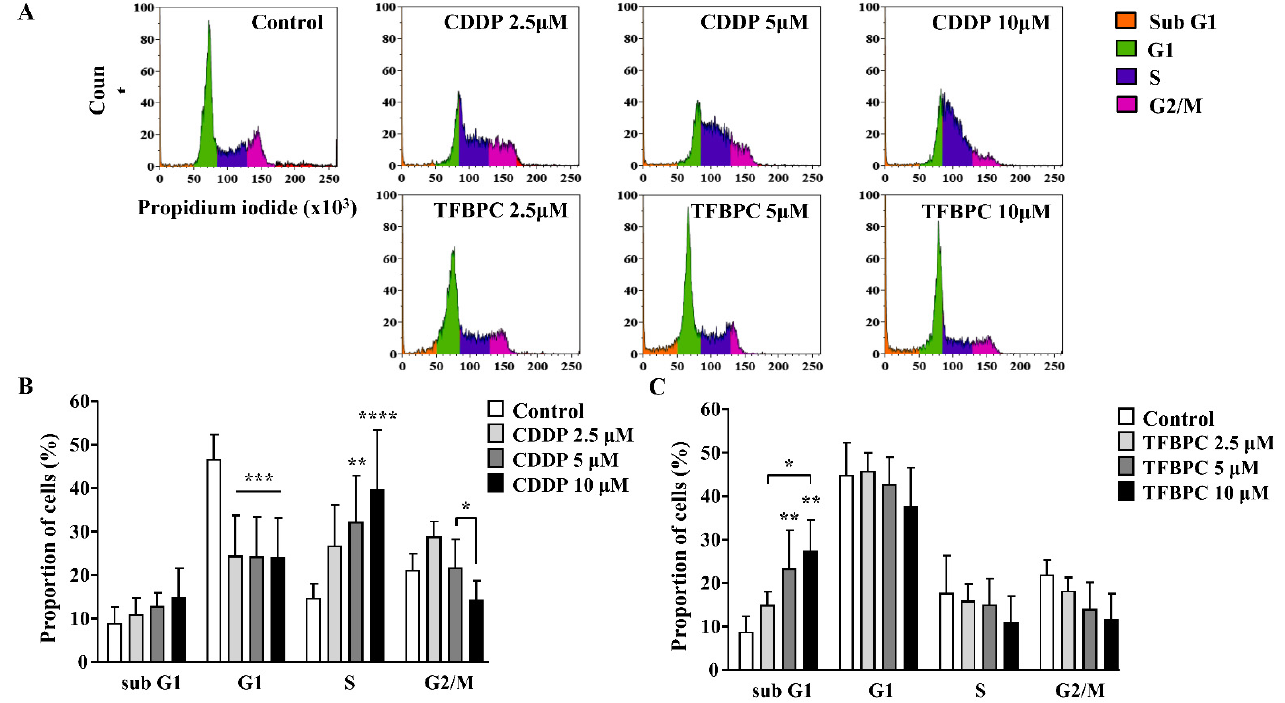
Figure 3. TFBPC and CDDP induced different routes of cell cycle arrest in MDA-MB-231 human breast cancer cells. After MDA-MB-231 cell incubation in 2.5, 5 and 10 μ M of CDDP or TFBPC for 24 h, cells were fixed and stained using propidium iodide to detect the DNA content using flow cytometry ( A ). Proportions of cells at four stages, sub G1, G1, S and G2/M were evaluated using Kaluza Analysis Software and represented as mean ± SD in bar graphs ( B , C ). * p < 0.05; ** p < 0.01; *** p < 0.001; **** p < 0.0001.